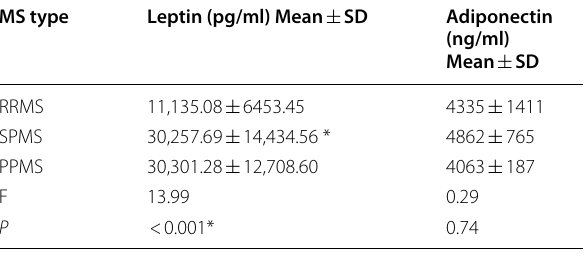
Table 2 Serum leptin and adiponectin levels in different types